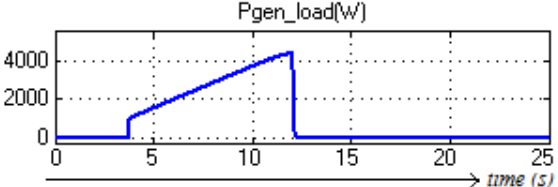
Fig. 7. Simulation diagram of load motor’s generated power.